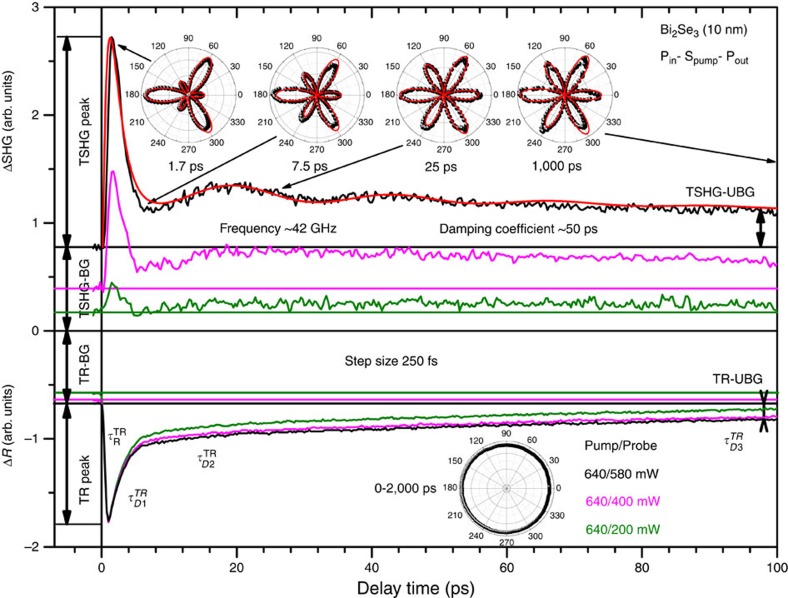
TR and TSHG traces for the 10 nm thick Bi2Se3 film.TR and TSHG traces for the 10 nm Bi2Se3 film simultaneously measured with 250 fs step-size in the Pin−Spump−Pout polarization geometry at different pump/probe powers as indicated by the corresponding colours. The assignment of TR-peak, TSHG-peak, TR-BG, SHG-BG, TR-UBG and SHG-UBG intensities are shown. The normalized TR rotational anisotropy and TSHGRA patterns measured at the fixed pump-to-probe delay times as indicated by arrows are shown in insets of the corresponding TR and TSHG sections of the graph. The red curves present the best fit to the data. The TSHG section also indicates the frequency and damping coefficient of the oscillatory part of the TSHG trace.